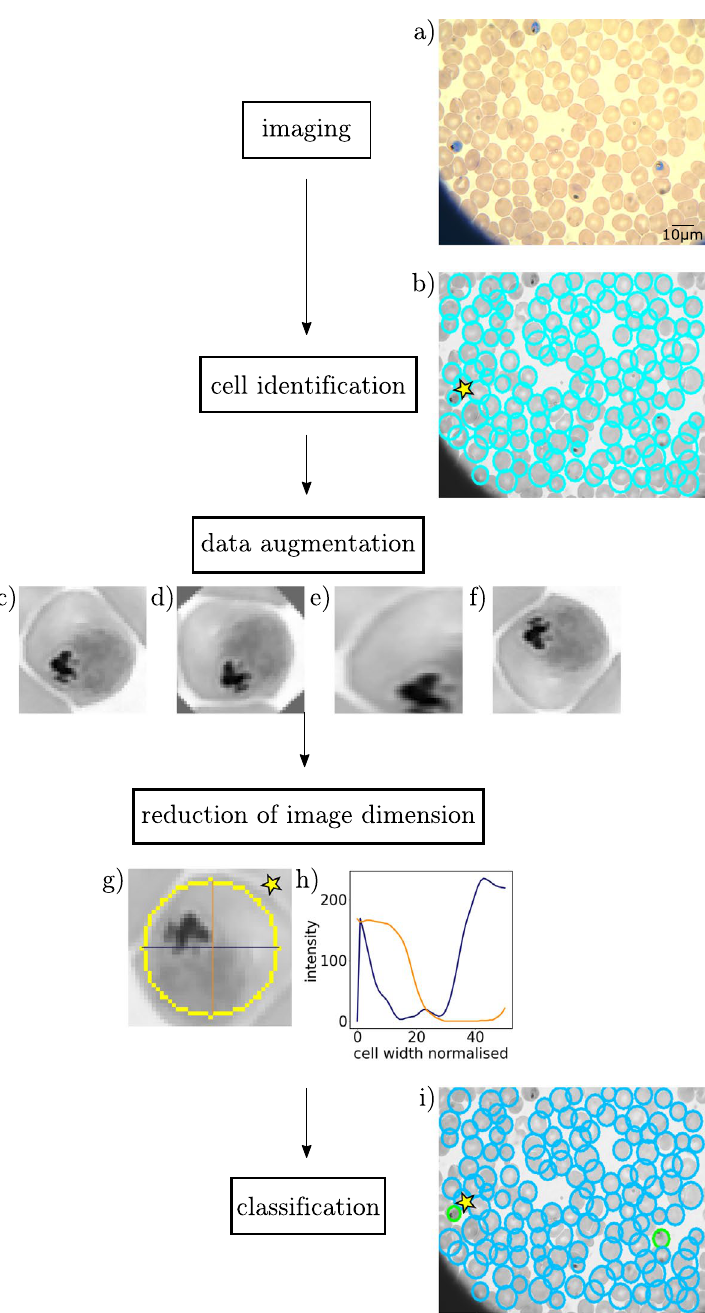
Figure 1. Schematics of the workflow for the stage-specific detection of malaria-infected RBCs. ( a ) Imaging: raw light microscopy image. ( b ) Cell identification: the detected cells are marked by cyan circles. ( c , d ) Data augmentation: the original image ( c ) is rotated ( d ), scaled ( e ), and reflected ( f ). ( g , h ) Reduction of image dimension: the most asymmetric cross-sections are extracted from the cell image. ( i ) Classification: the identified cells are classified by a neural